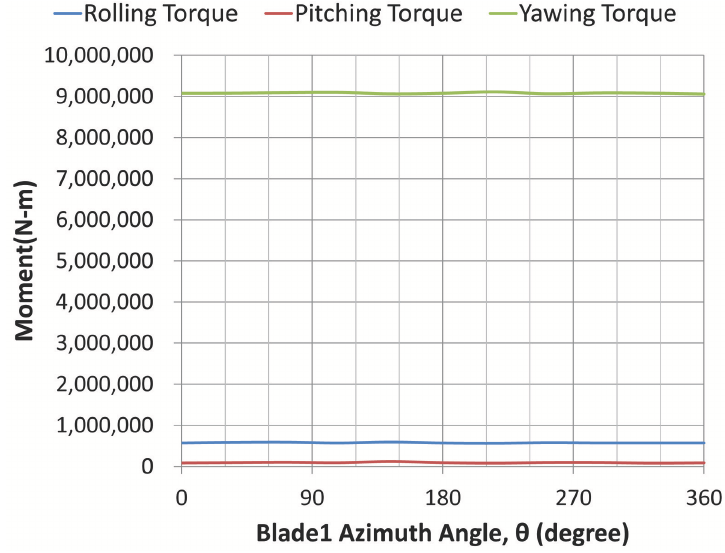
Figure 16. Moment vs. azimuth angle with respect to the x -, y - and z -axes at the anchoring